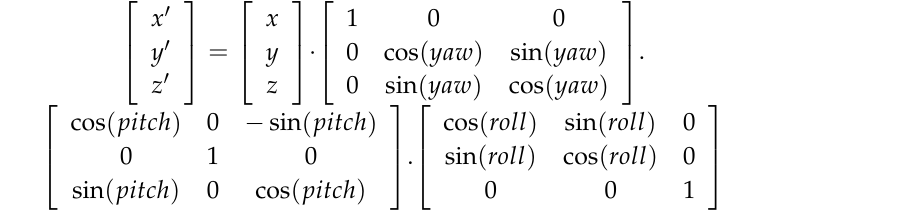
Position System (GPS)’s signals is P1. P2 is the result of mapping the signals of GPS with adapting GIS